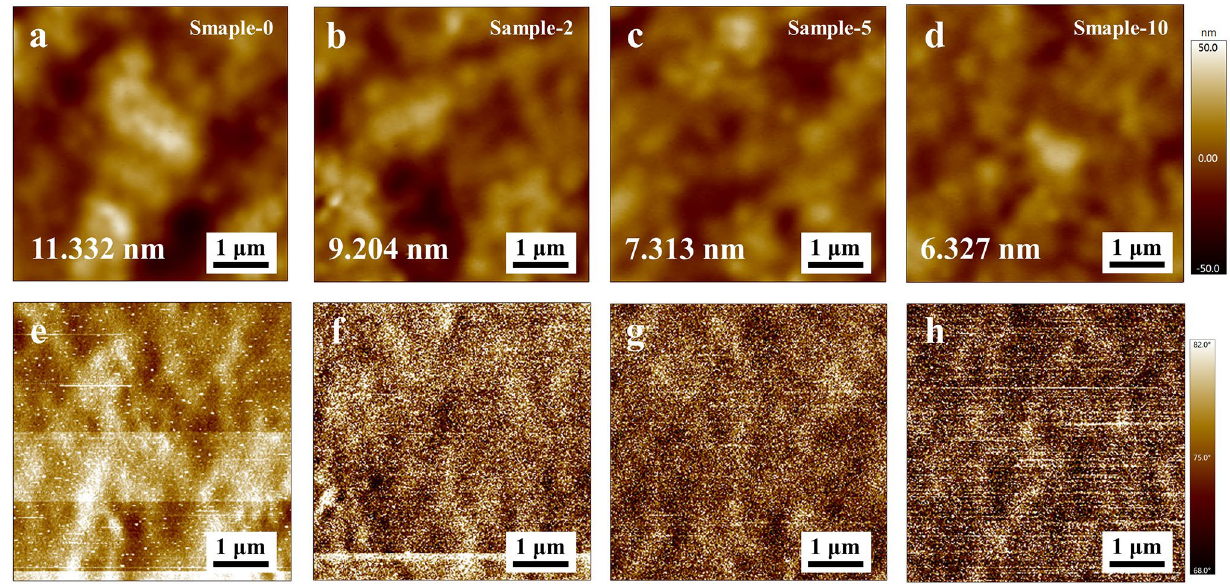
Fig. 3 Characterization of the ISTL (AgI) on the surface of spiro-OMeTAD. a‑d The xy-plane film morphology of spiro-OMeTAD and spiro- OMeTAD/AgI fabricated with different thickness of Ag (2, 5 and 10 nm), respectively, measured by atomic force microscopy (AFM). e–h The corresponding phase images. All the samples were stored in the dark for 24 h before